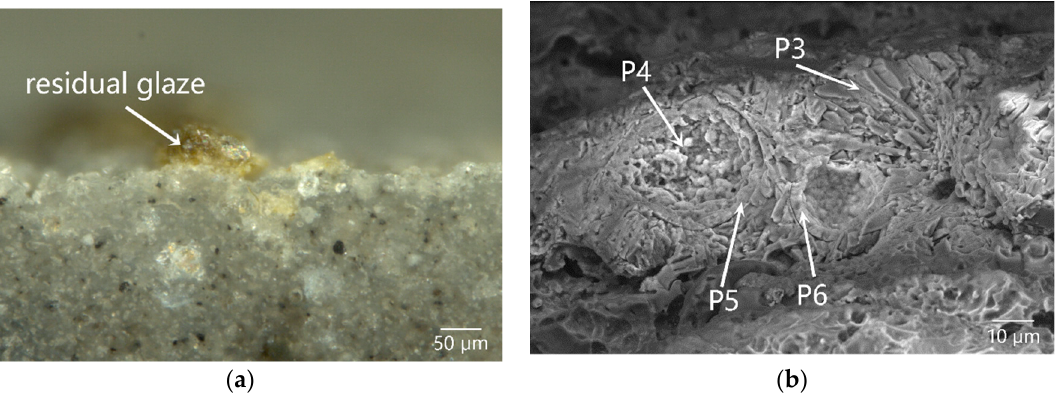
Figure 4. Cross-sectional morphology of the residual glaze on the outer surface of sample DL-2: ( a ) OM image and ( b ) SEM image, showing foreign pollutants deposited in the pores in the residual body/glaze interlayer.